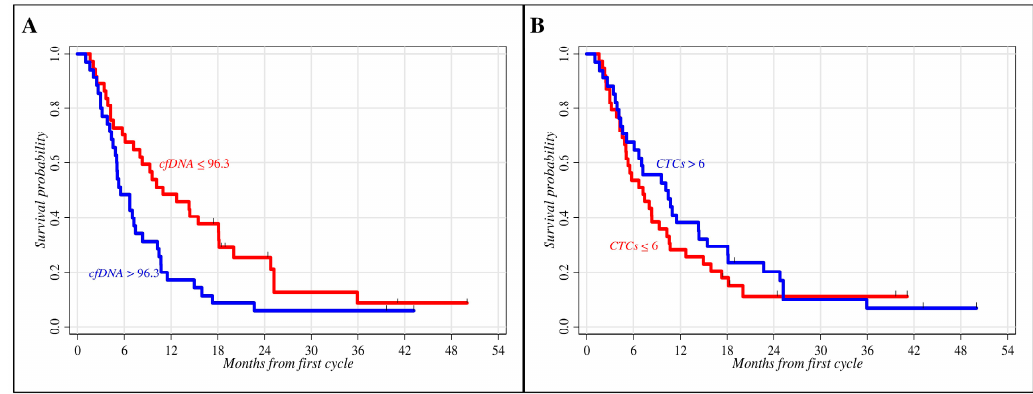
Figure 1. Overall survival according to circulating biomarkers at baseline by Kaplan–Meier analysis. Non-small cell lung cancer (NSCLC) patients were divided into two groups according to median baseline values. ( A ) Cell-free DNA (cfDNA): 96.3 human Telomerase Reverse Transcriptase ( hTERT ) copy number ( p -value = 0.019); ( B ) Circulating tumor cells (CTCs): 6 CTCs/3 mL of blood ( p -value = 0.402).